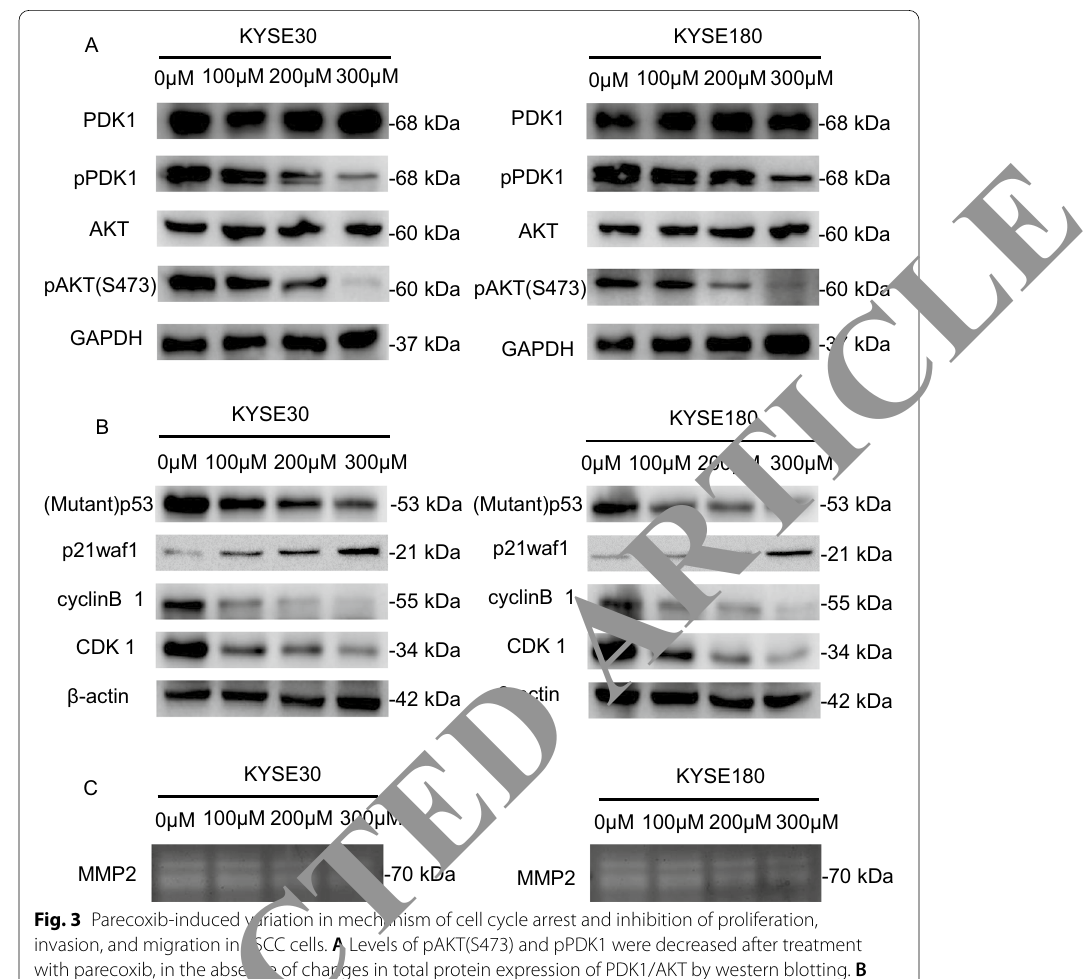
Fig. 3 Parecoxib‑induced variation in mechanism of cell cycle arrest and inhibition of proliferation, invasion, and migration in ESCC cells. A Levels of pAKT(S473) and pPDK1 were decreased after treatment with parecoxib, in the absence of changes in total protein expression of PDK1/AKT by western blotting. B The variation of critical regulatory proteins for the transition from G2 to M phase was detected by western blotting. Mutant p53, cyclin B1, and CDK1 were decreased, while p21waf1 was increased. C , D Parecoxib suppressed ECM degradation of ESCC cells by the inhibition of MMP2 secretion ( C ) and invadopodia formation ( D ). Images represented three independent experiments. Data are mean of three independent experiments. The data are shown in Additional file 1: Fig. S1. * P < 0.05, ** P < 0.01, and *** P <